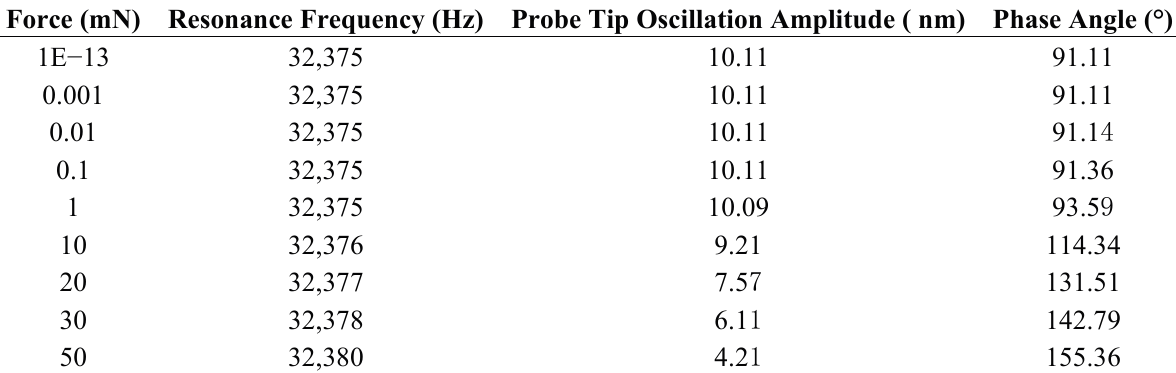
Table 7. Dynamic response of the TF-probe under a longitudinal force.